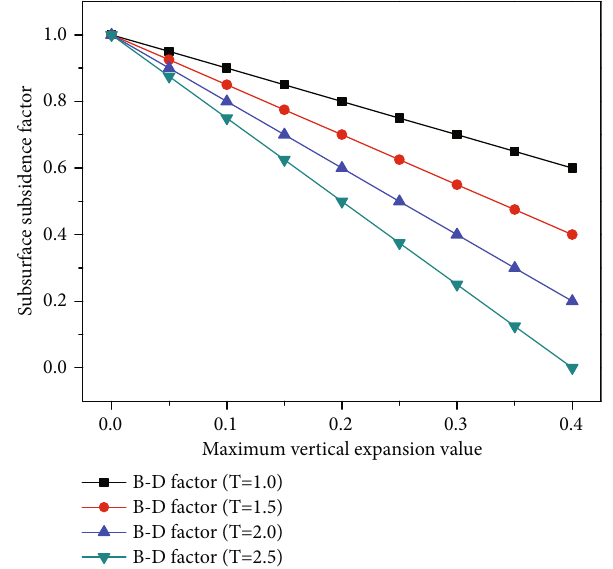
Figure 7: Relation between the surface subsidence factor and maximal vertical expansion